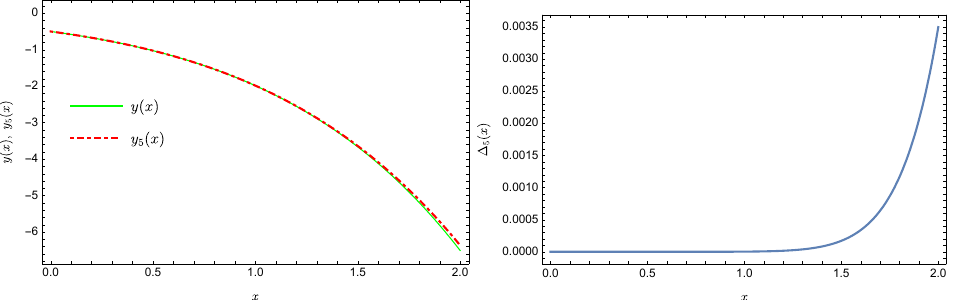
Figure 13. Exact solution and the approximate solution y 5 ( x ) together with the error ∆ of this approximation.